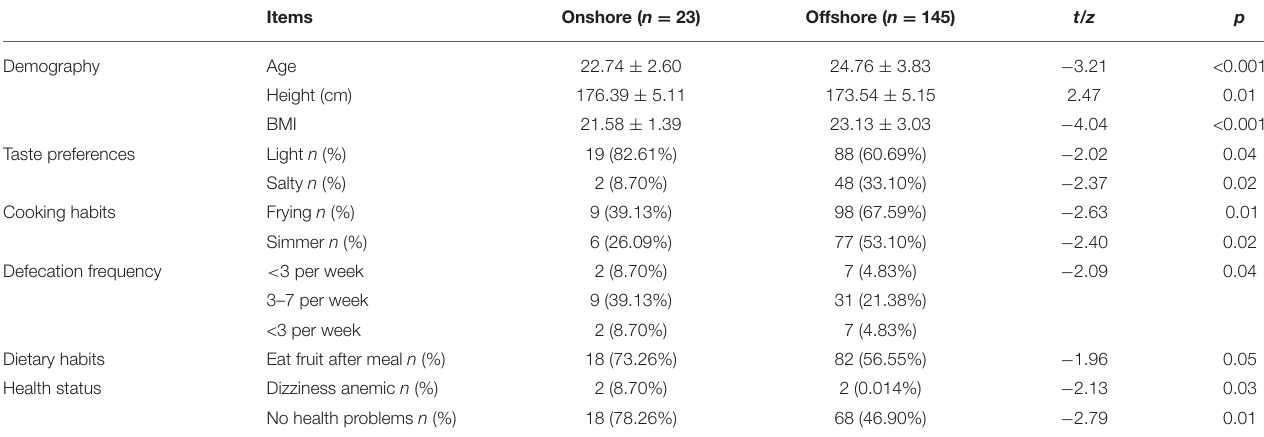
TABLE 1 | Items with statistical differences ( p <